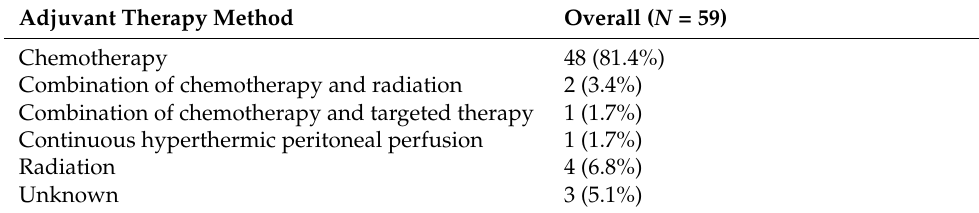
Table 3. The details of postoperative adjuvant therapy methods for 59 AC patients undergoing curative pancreatoduodenectomy.